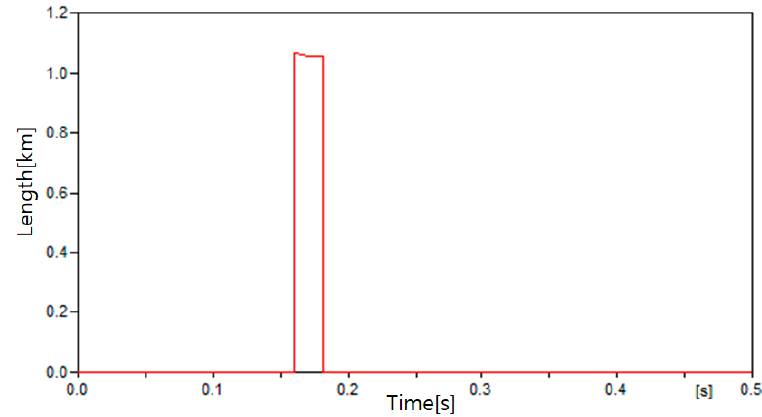
Figure 7. Fault location in Case 1.